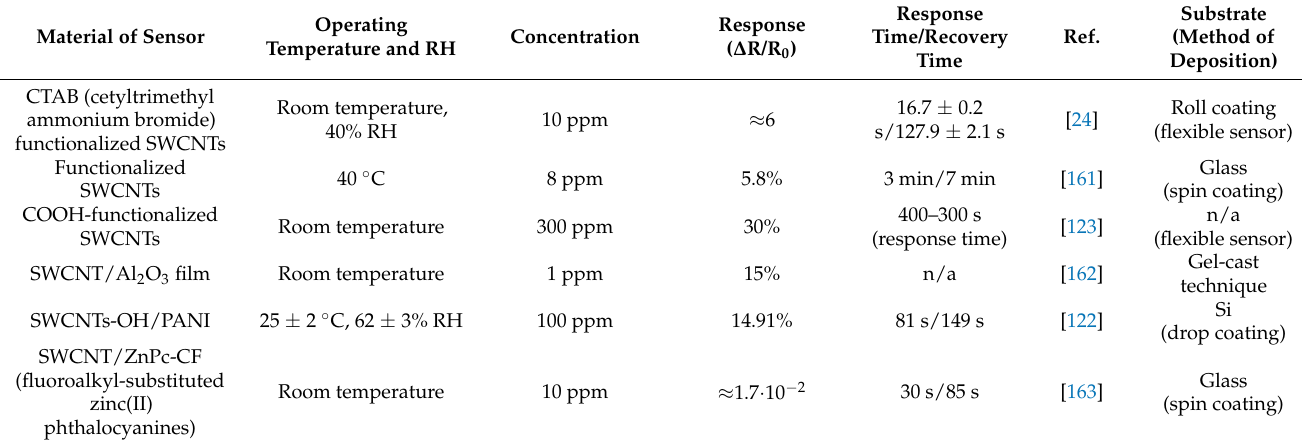
Table 1. Characteristics of ammonia gas sensors based on SWCNTs and